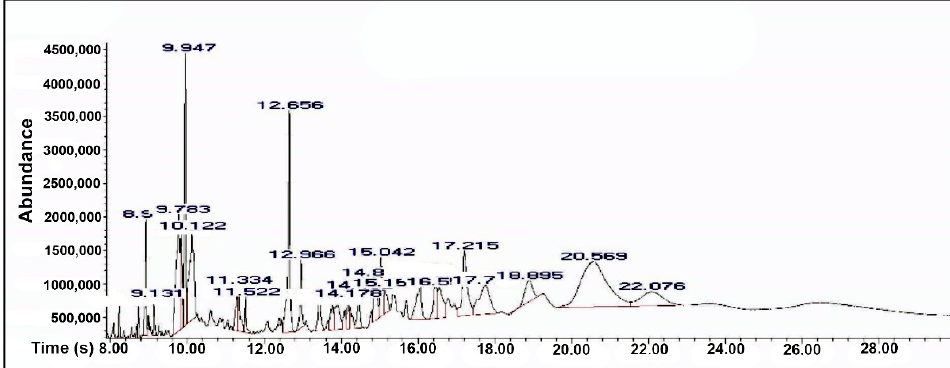
Figure 2. Gas chromatography-mass spectrometry (GC-MS) profile of the L. nobilis leaves smoke .